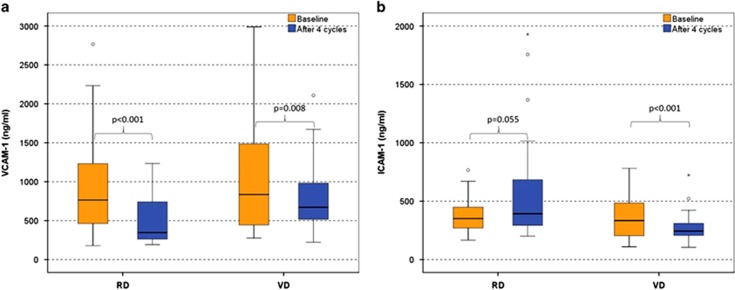
Alterations of VCAM (a) and ICAM (b) post four cycles of RD and VD; whisker plots (open circles) refer to outlier values, while 'extreme' values are marked with an asterisk.